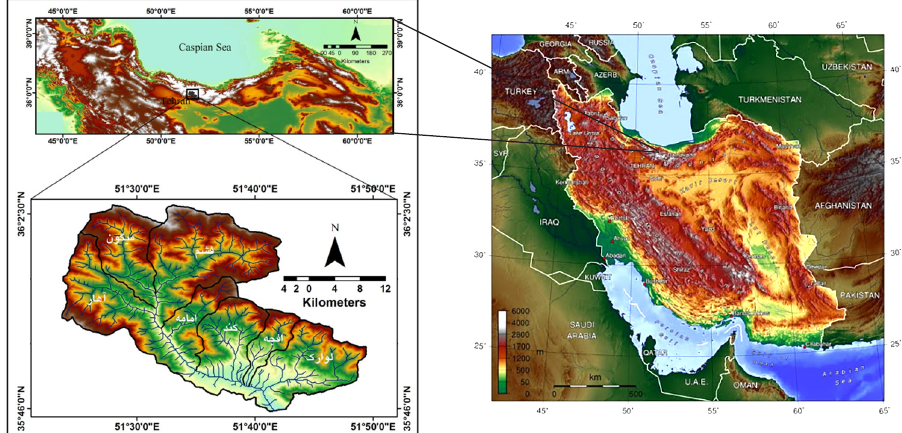
Figure 1. Location of study